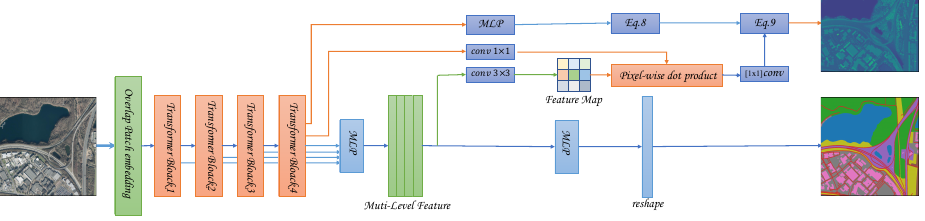
Figure 6. Our Network